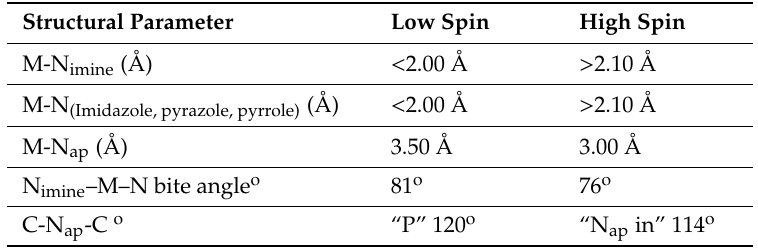
Table 2. Theoretical structural parameters [21,22] for LS and HS complexes of iron(II) or iron(III) tren(imidazole) 3 complex.